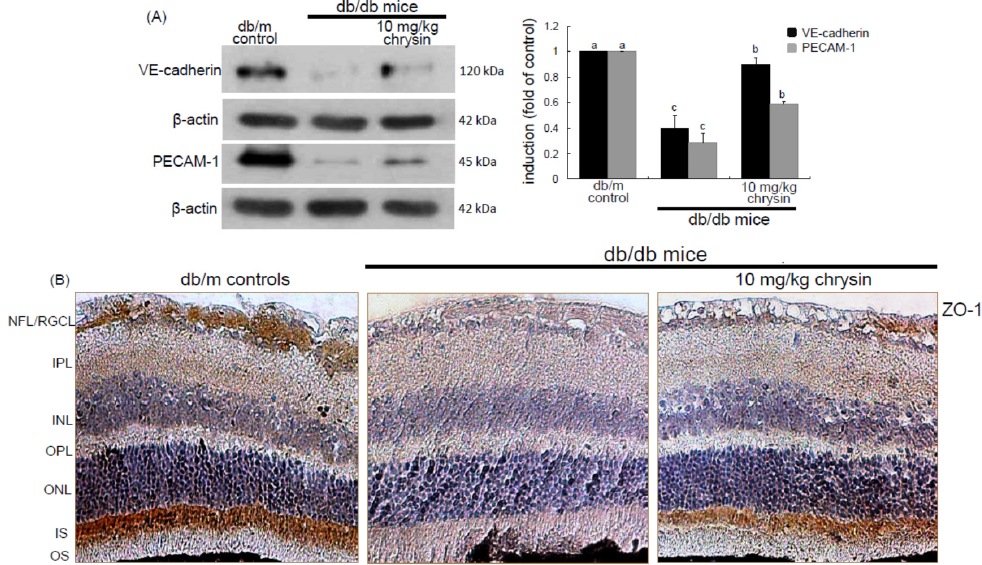
Figure 4. Induction of endothelial junction markers of VE ‐ cadherin, PECAM ‐ 1, and ZO ‐ 1 by chrysin. The db/db mice were orally supplemented with 10 mg/kg chrysin daily for 10 weeks. The db/m mice were introduced as control animals. Mouse retinal tissue extracts were subject to Western blot analysis with a primary antibody against VE ‐ cadherin and PECAM ‐ 1 ( A ). β‐ Actin protein was used as an internal control. Bar graphs (mean ± SEM, n = 3) in the right panel represent densitometric results of left blot bands. Values not sharing a common letter differ, p < 0.05. Histological sections of mouse retina were immunohistochemically stained using a primary antibody of ZO ‐ 1 ( B ). The ZO ‐